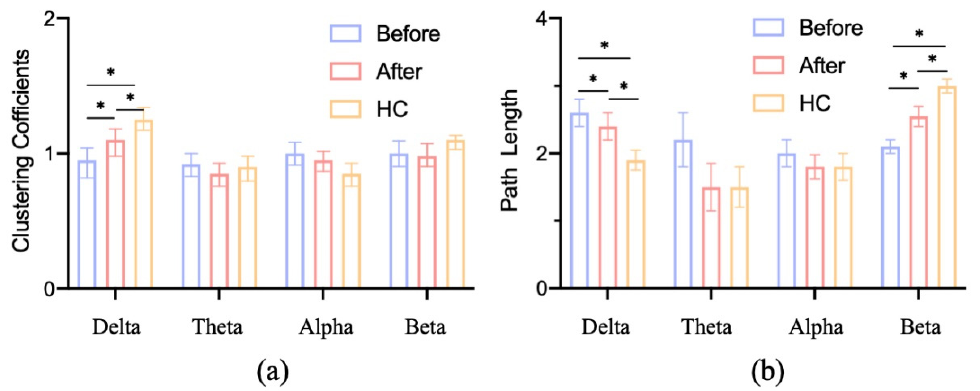
Figure 4. EEG functional brain network results. ( a ) Clustering coefficient, ( b ) characteristic path length. * p < 0.05, data are expressed as mean ± SEM.